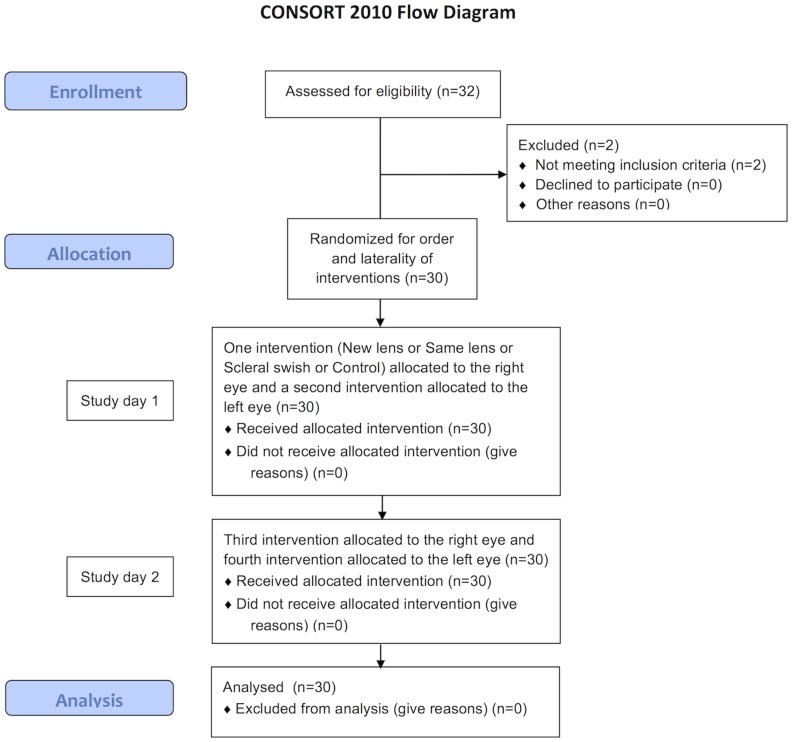
CONSORT Flow Diagram.